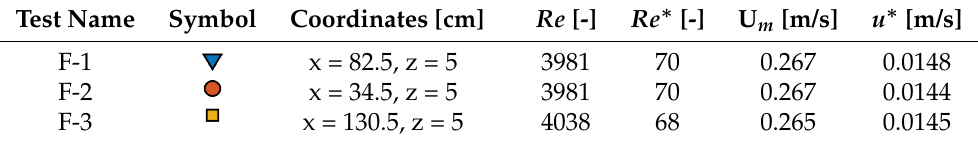
Table 1. Summary of the chosen hydraulic conditions to perform the flow-dynamic tests. The columns indicates: the Reynolds number, Re = Uh/ ν , the viscous Reynolds number, Re ∗ = u*h/ ν , the √ τ 0 / ρ . For all tests, 2000 image pairs (window maximum speed, U m and the friction velocity, u* = size 34.5 mm × 5 mm) were analyzed with a grid step size of 16 × 16 pixels and a spatial accuracy of 0.19 × 0.19